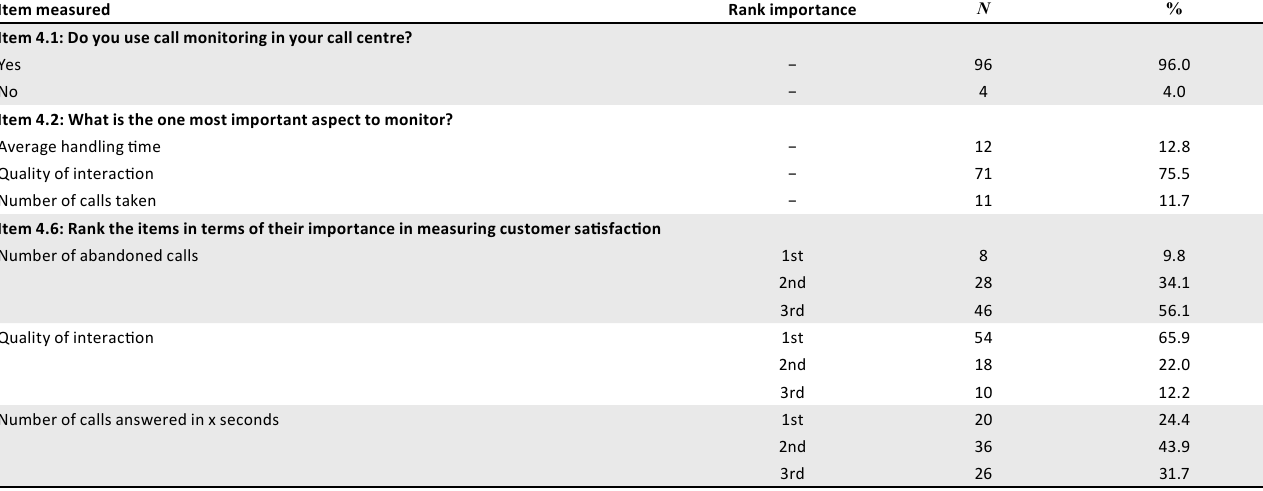
TABLE 3: Call monitoring, monitoring measures and customer satisfaction measures.